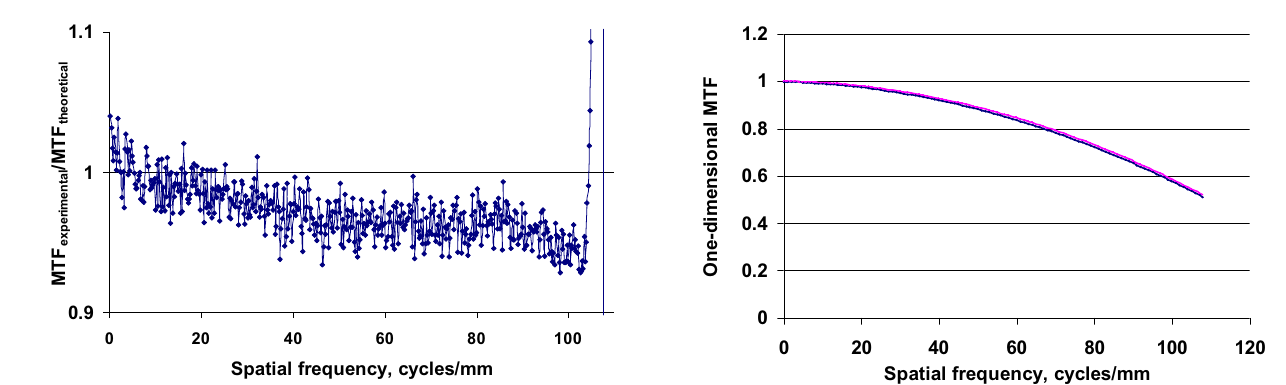
Fig. 6. Second order fits to the one-dimensional MTFs ob- tained at 470 nm (blue curve) and at 628 nm (red curve).